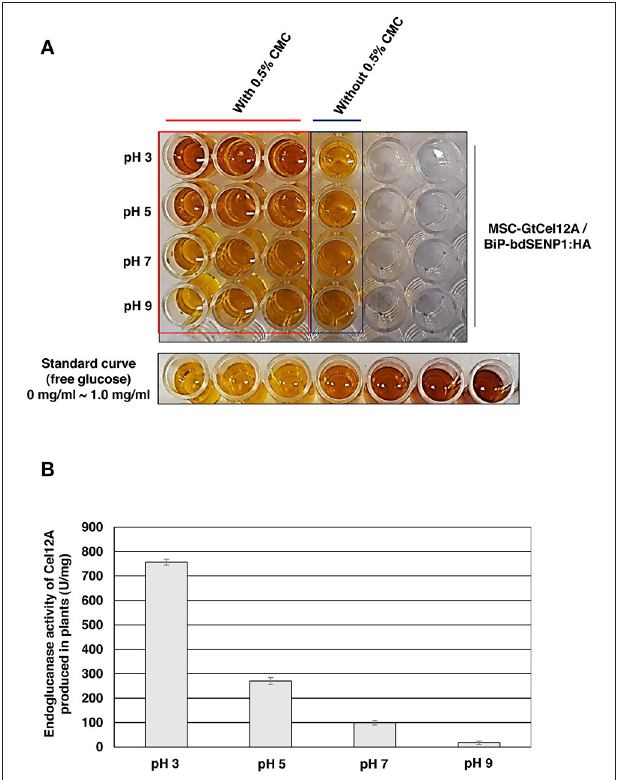
FIGURE 5 | GtCel12A-CBM3 immobilized on MCC beads exhibits efficient endoglucanase activity at pH 3.0 . (A) Endoglucanase activity of GtCel12A-CBM3 immobilized on MCC beads was determined at indicated pH by measuring the reducing sugar content using dinitrosalicylic acid (DNS) assay. The enzyme reaction was performed at 50 ◦ C. The endoglucanase activity is shown by the change in DNS color. (B) Quantification of specific GtCel12A-CBM3 activity. One unit (U) is defined as the amount of GtCel12A-CBM3 that can release 1 µ mol of glucose from CMC per min. All the reactions were performed three times (biological replicates) and each reaction was performed in triplicate per plate (technical replicates). Data represent means ( n = 3) ± standard deviation in which n represents biological replicates.